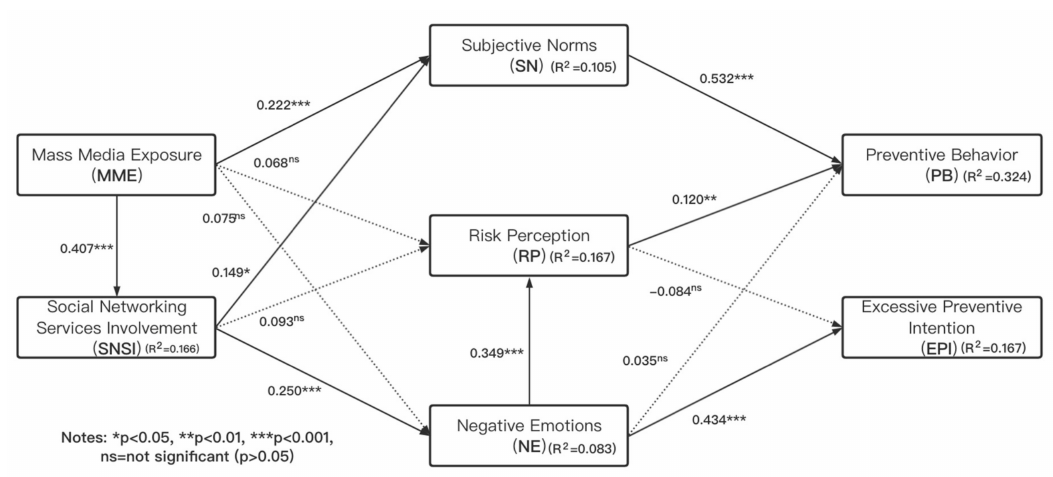
Figure 3. Results of the structural model analysis for the other regions